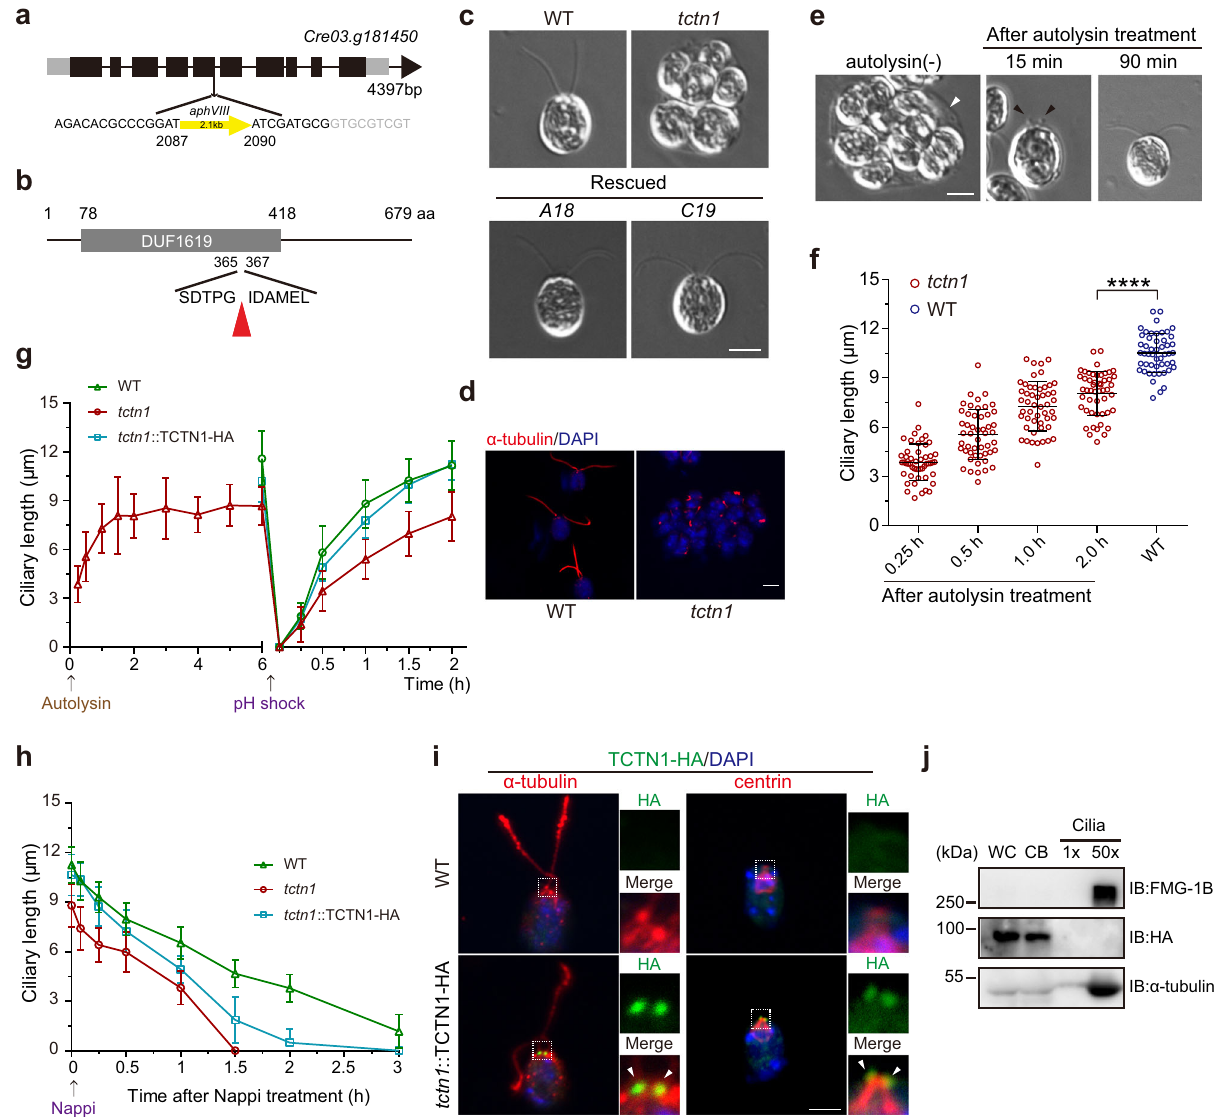
Fig. 1 Characterization of the C. reinhardtii tctn1 mutant. a Diagram of the gene structure of TCTN1 ( Cre03.g181450 ) with the aphVIII DNA insertional site. b Diagram of the domain structure of the TCTN1 protein. The TCTN1 protein (679 aa) contains the DUF1619 domain (78 – 418 aa) with unknown function. The red arrowhead marks the insertional site. c DIC images showing the ciliary phenotypes of WT, mutant, and rescued cells ( A18 , C19 ). Scale bar, 5 μ m. d Immunostaining images depicting the very short cilium within the palmelloid of tctn1 . The red signals (by anti- α -tubulin antibody) mark the cilia and the blue signals (by DAPI) mark the nucleus. Scale bar, 5 μ m. e DIC images depicting the ciliary phenotype of tctn1 after treatment with autolysin. The mother cell walls are indicated by white arrowhead and the ciliary bugles are indicated by black arrowheads. Scale bar, 5 μ m. f Scatter plot showing the elongation of cilia in e . Statistical signi fi cance was determined with an unpaired t test. **** P < 0.0001 by two tailed. g tctn1 exhibited shorter cilia after hatching with autolysin and slower kinetics of ciliary assembly. The arrow indicates the time point of autolysin or pH shock treatment. h tctn1 exhibited faster kinetics of ciliary disassembly. The arrow indicates the time point of Nappi treatment to induce ciliary shortening. i Immunostaining showing the localization of TCTN1 in the TZ. Cells were immunostained with HA (green) and α -tubulin (red, left) or centrin (red, right) antibodies. The nucleus was stained with DAPI (blue). The arrowheads indicate the TZ. The dotted boxes indicate the regions of higher magni fi cation views. Scale bar, 5 μ m. j Immunoblot analysis of the localization of TCTN1-HA in the rescued cell line. 1× (cilia) represents an equal proportion of cilia to that of the cell body (two cilia per cell body). 50× (cilia) represents equal cilia and cell body proteins. WC whole cell, CB cell body. Ciliary lengths are shown as the mean ± SD of 50 cilia. Source data are provided as a Source Data fi